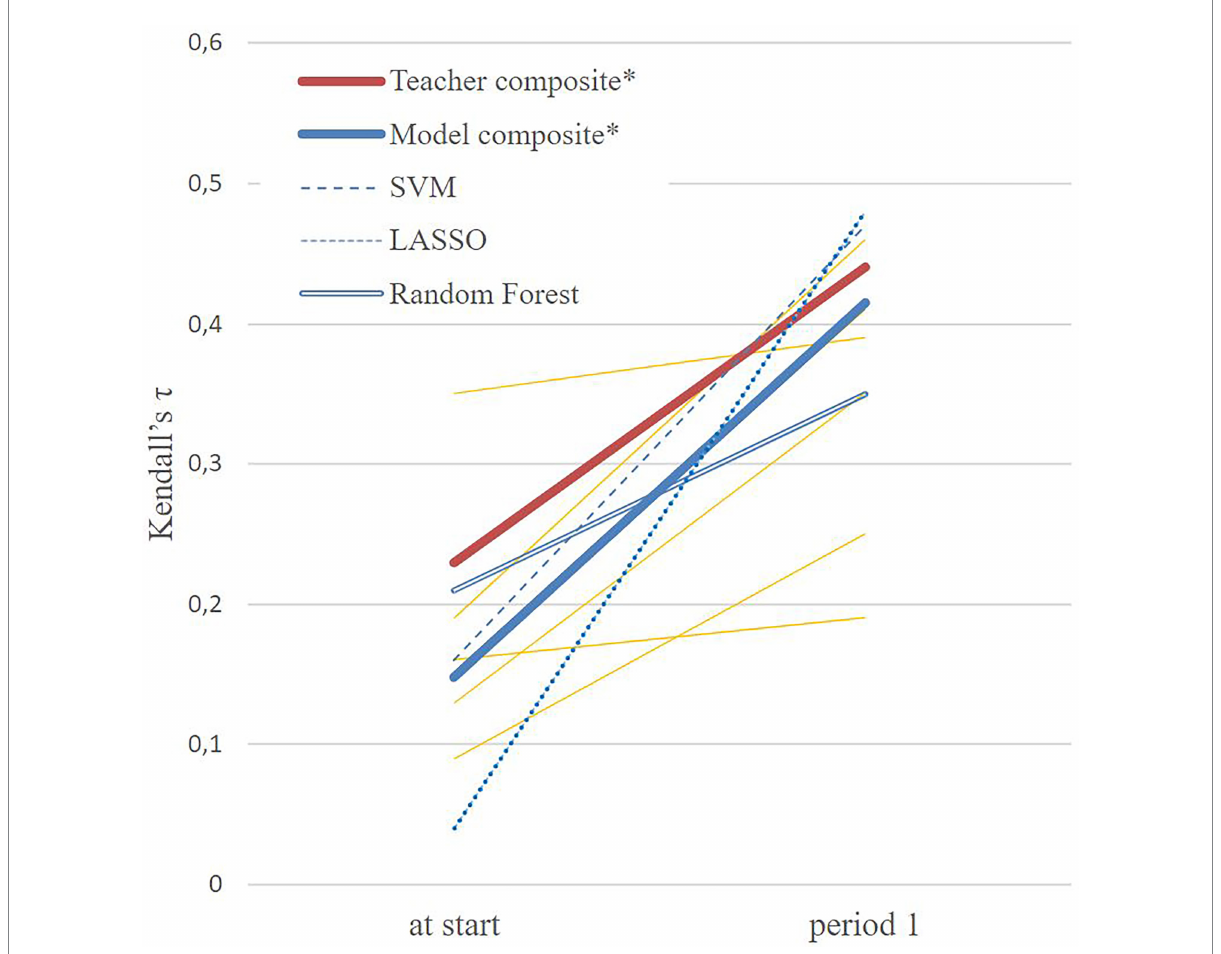
FIGURE 1 Kendall’s τ (tau-b, adjusted for ties) of the teachers (yellow lines) and the machine learning algorithms at the start of the program and after period 1 (at a cut-off of 0.5). Table B1 in Appendix B shows all information. *The outcomes of the calculated teacher composite (by combining the teacher predictions and certainties) and model composite differ from just simply averaging all teacher and model